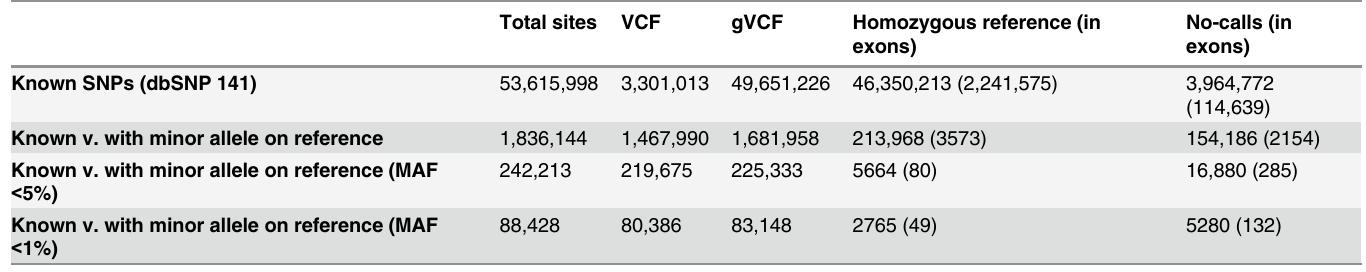
Table 3. Genotyping of known SNPs from dbSNP 141 using the VCF and gVCF file formats and the number of homozygous reference sites and no- calls based on WGS